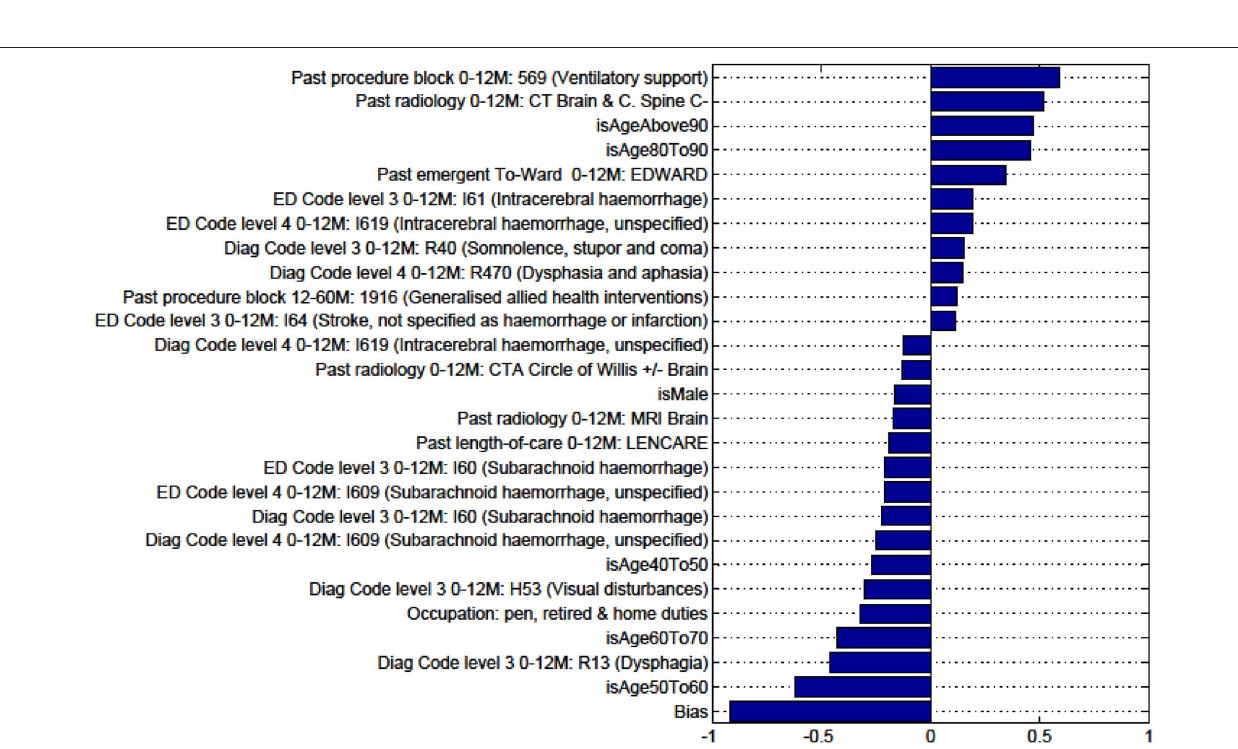
Frontiers in Neurology |